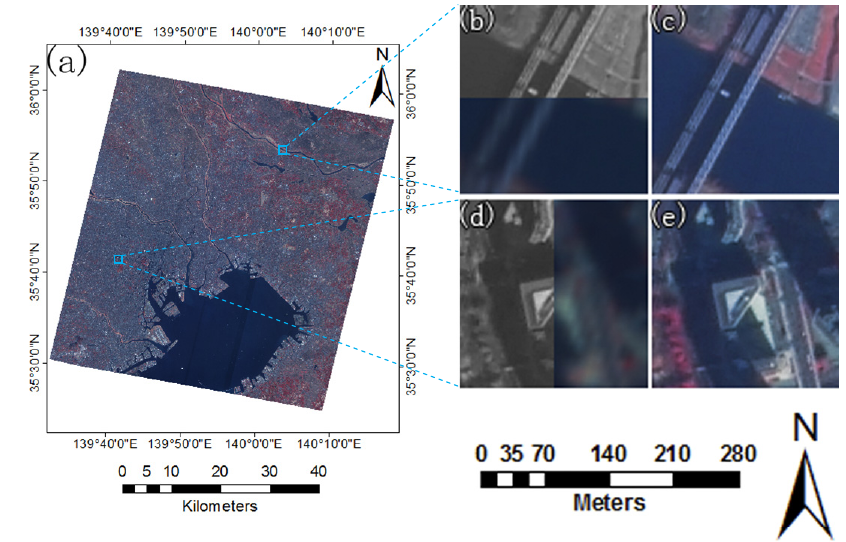
Figure 9. Registration and fusion results of Dataset 3. ( a ) provides an overall view of fused images, ( b ) shows the swipe effect of registered images in the first cyan rectangular area, ( c ) shows the fusion result, ( d , e ) show the result in the second rectangular area.